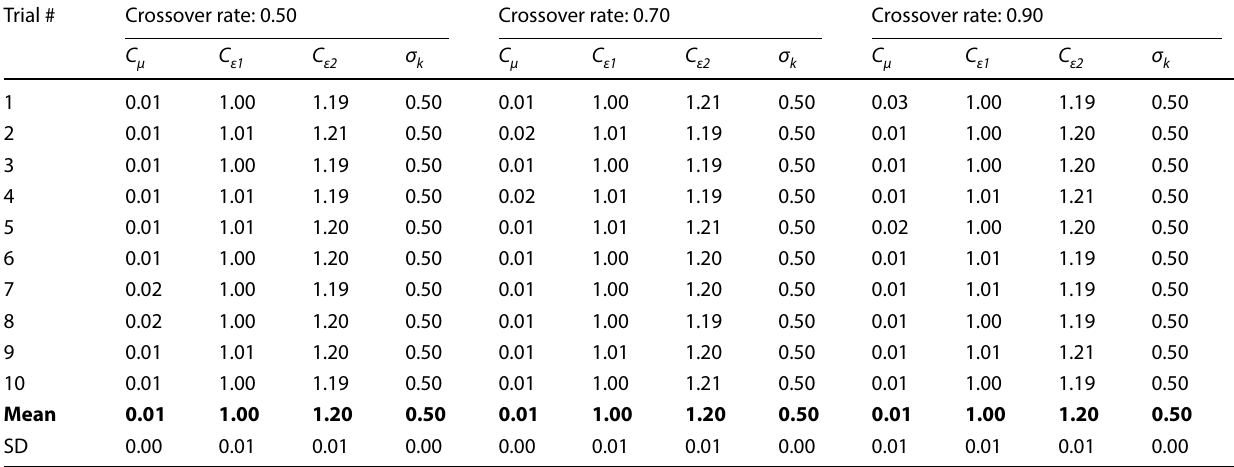
Table 8 Effect of crossover rate on GA-based simulation results for mutation rate 0.05 and channel configuration p/k = 10, H = 1.2 mm.